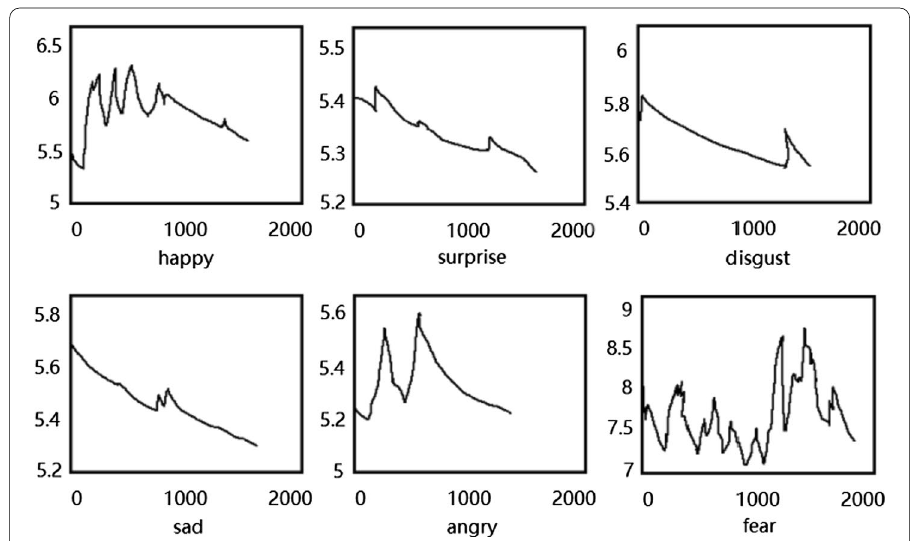
Fig. 2 The relationship between common emotions and